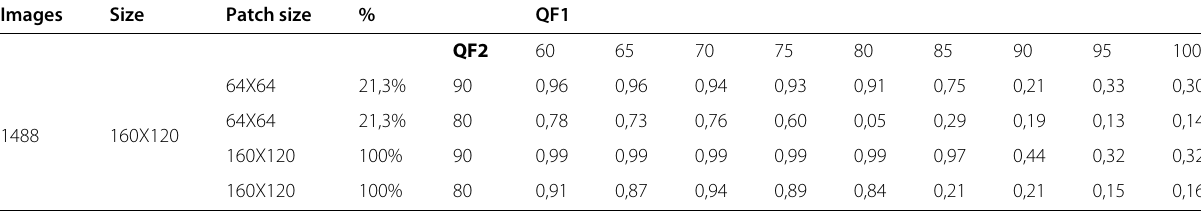
Table 3 Accuracy obtained by the proposed approach on Dresden [33] dataset with different patch size and QF 1 / QF 2 Images